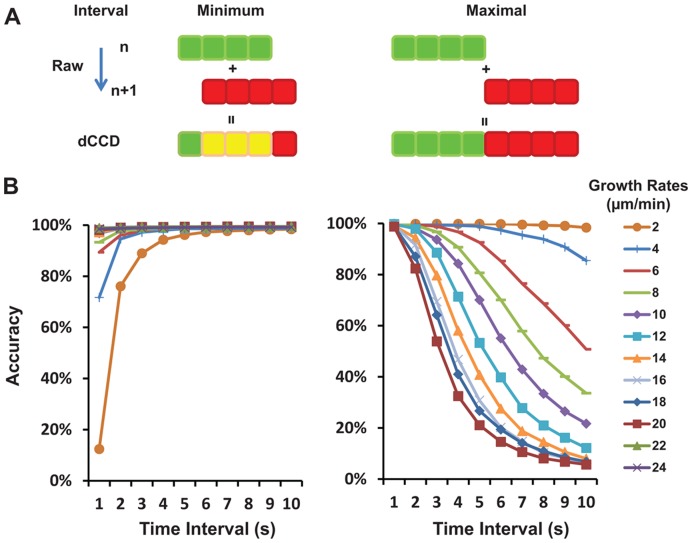
Analysis to identify minimum and maximal intervals for the dCCD method. A.A simple model to illustrate the limits of image intervals used for the dCCD method. Colored EB3-GFP labels are represented by linear arrays of colored squares equivalent to the pixels in digital images. The minimum interval (left) is defined as the time needed to detect the movement of the array from the nth frame (shown in green) to the n+1th frame (in red), leading to a new array with at least one red square followed by yellow and green squares in the merged dCCD images. The maximal interval (right) is defined as time allowed for the movement of one array length (4 pixels shown here) in the n+1th frame. B. Relationship of accuracy and time interval based on the numerical simulation using the criteria for minimum (left) and maximum (right) intervals defined in (A). For the minimum interval, accuracy is calculated as the number of ends that have moved at least one pixel length over 1000 total ends used in the simulation, whereas for the maximum interval, accuracy is calculated as the number of ends moved for less than the label length over 1000 simulated ends. Note the opposite relationship between the accuracy and the minimum or maximum interval. For fast growing microtubules (>14 µm/min), intervals >1 sec provide 98% accuracy for the minimum interval and <1 sec intervals give the same accuracy for the maximal interval. For slow growing ends found in the COS cell (4 µm/min), intervals between 3 sec and 7 sec can provide 95% accuracy.